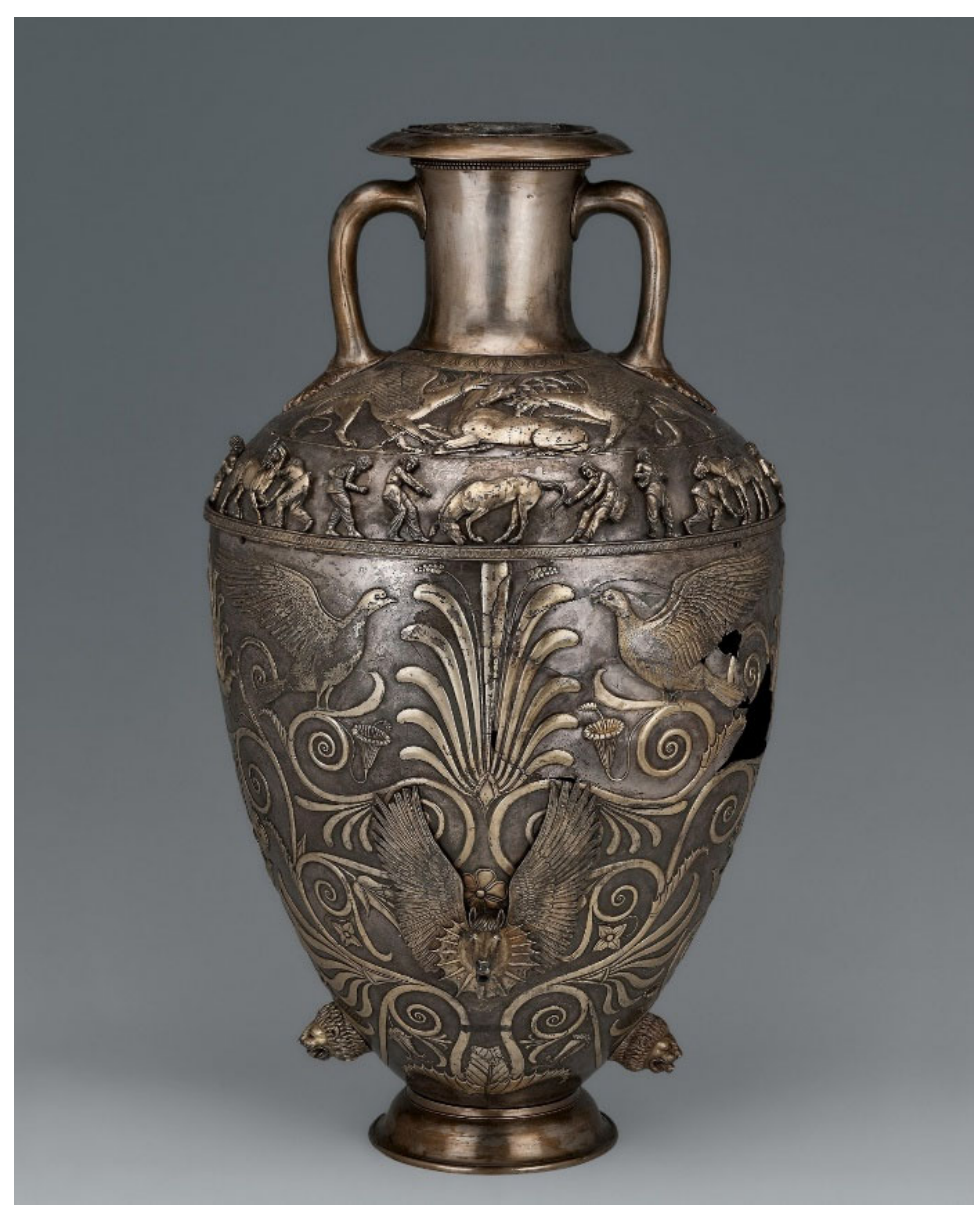
Figure 31. Amphora (SHM inv. no. Дн .1863-1/166); cast, embossed, chased, engraved, and gilded silver; Chertomlyk kurgan, Dnepropetrovsk region, Ukraine; 350–325 BC. [Image is used from